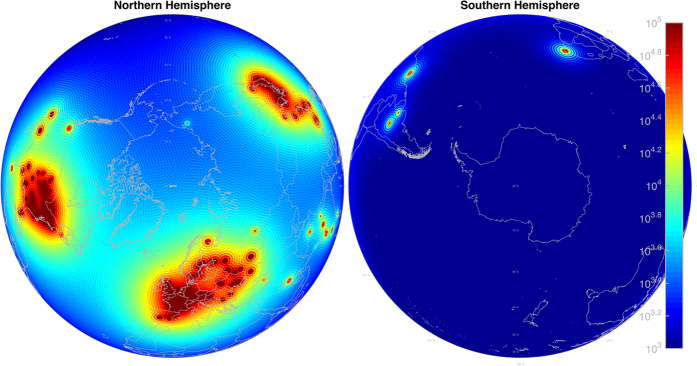
AGM2015 reactor- flux in the 3.00–3.01 MeV energy bin (in logspace color).Flux units are  at the Earth’s surface. Note the visible θ12 oscillations at ~100 km wavelength. Figure created with MATLAB45.